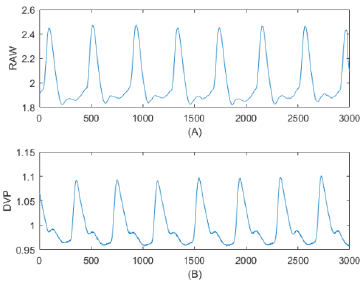
Figure 1. According to the quasi-periodic signal, ( A ) radial arterial waveform from the left wrist [5] and ( B ) digital volume pulse from the left index finger [24] could be regarded as cyclo-stationary, which is a signal having statistical properties that vary cyclically with time. Both waveforms con- sisted of 3000 consecutive points of sampled data over 6 s at a 500 Hz sampling